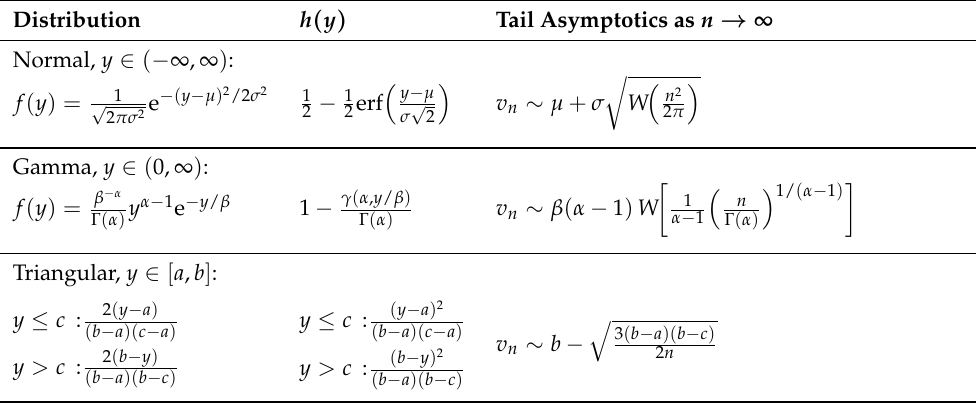
Table 1. This table details the behaviour of v n in the large- n limit for several common probability density functions. For each example, the table contains the pdf equation f ( y ) and the density domain. The next column contains the survival function h ( y ) . The final column shows the asymptotic behaviour of v n in the limit n → ∞ . In each case, v n increases without